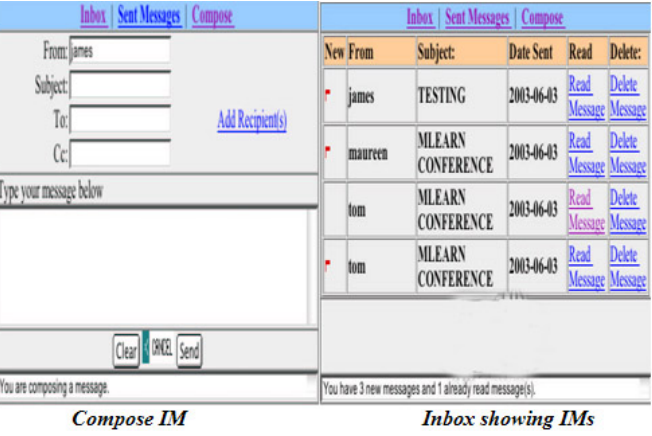
Figure 3a, a snapshot of an empty instant message screen. Figure 3b, a snapshot of a user's inbox showing instant messages